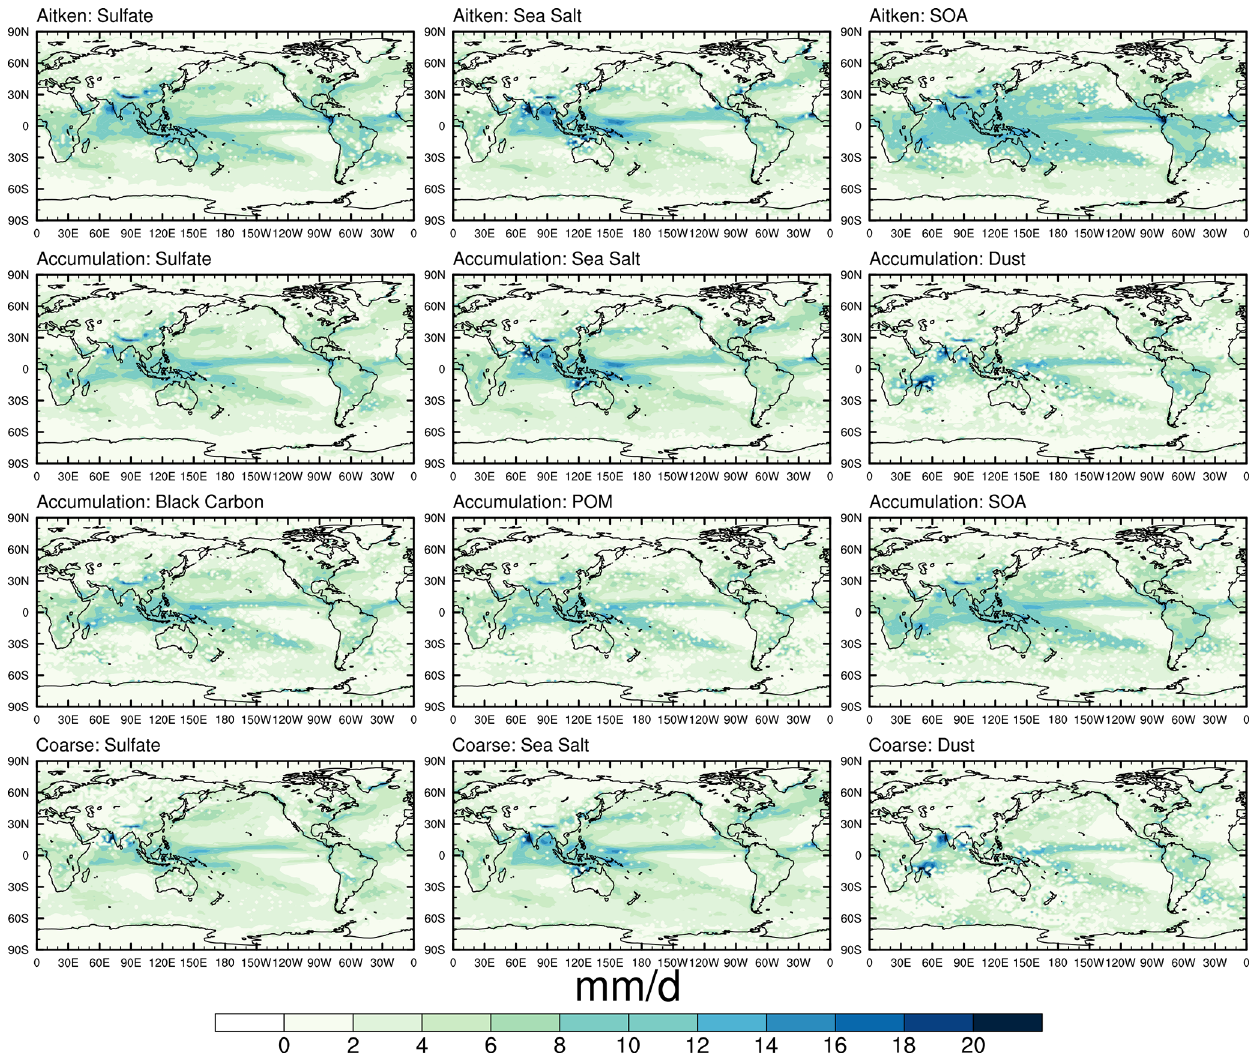
Figure 11. Global distributions of the rainfall intensity associated with 50% of the accumulated wet removal of aerosols for CAM5.